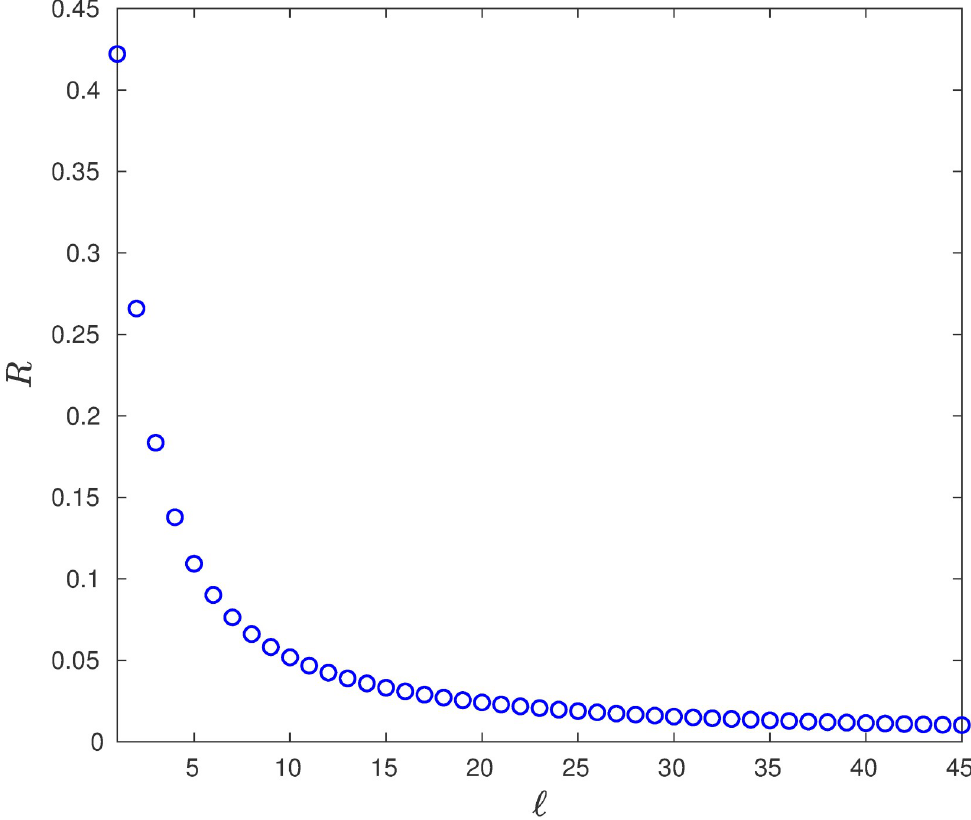
Fig 7. The steady-state output rate R as a function of ℓ 2 {1, 2, ... , 45} for a EFEIOD with n = 100, λ 0 = 1, λ i = 1, α i = 0, for all i , q = 0.01 and r = 1/ q